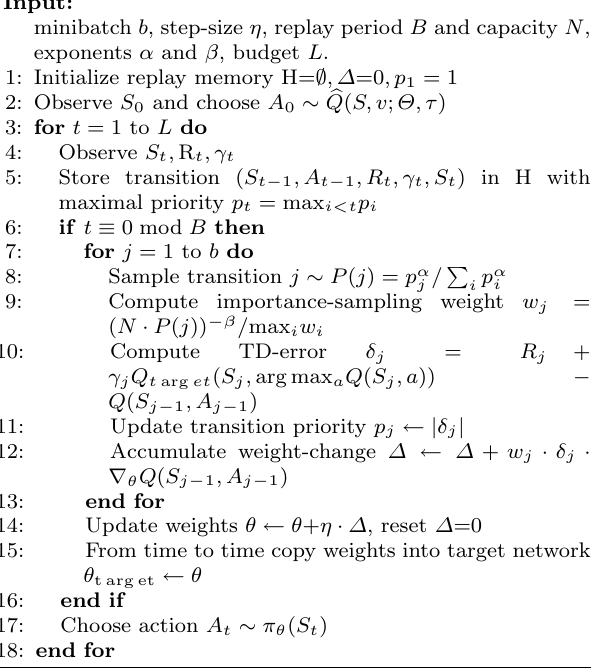
Algorithm 1 Double DQN with prioritized